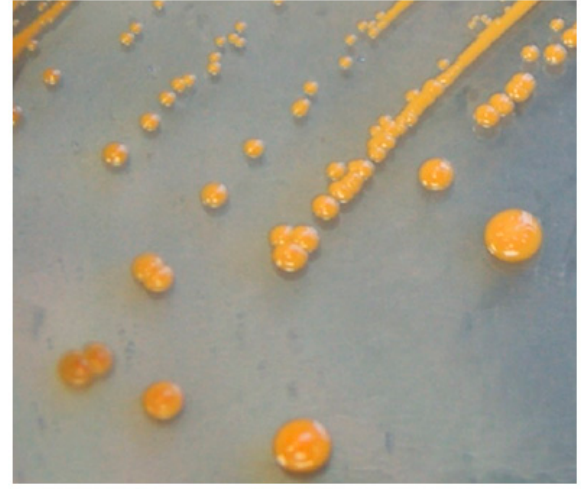
Figure 1. Sphingomonas sp. JX444564 (S11) colonies.